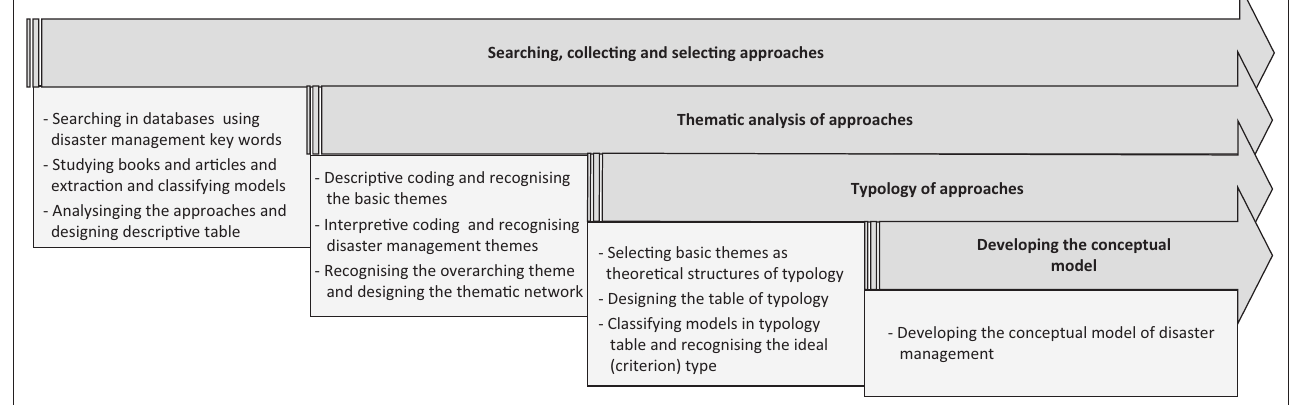
FIGURE 1: Research process in order to reach a conceptual model of disaster